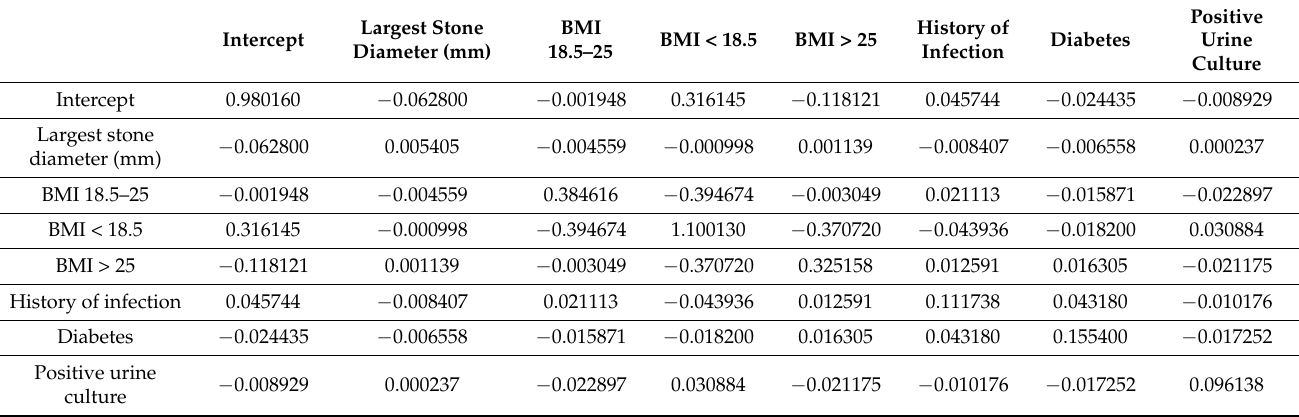
Table 5. Estimated variance-covariance matrix.